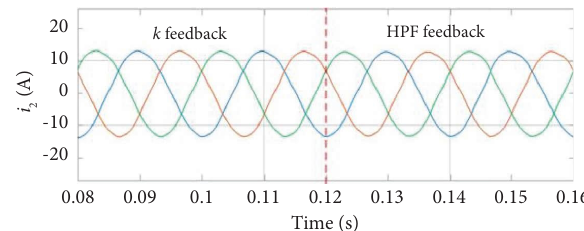
Figure 11: Simulated grid currents of the three-phase LCL-fltered grid-tied inverter system with diferent capacitor current feedback methods when L g � 3.6 mH and C g �